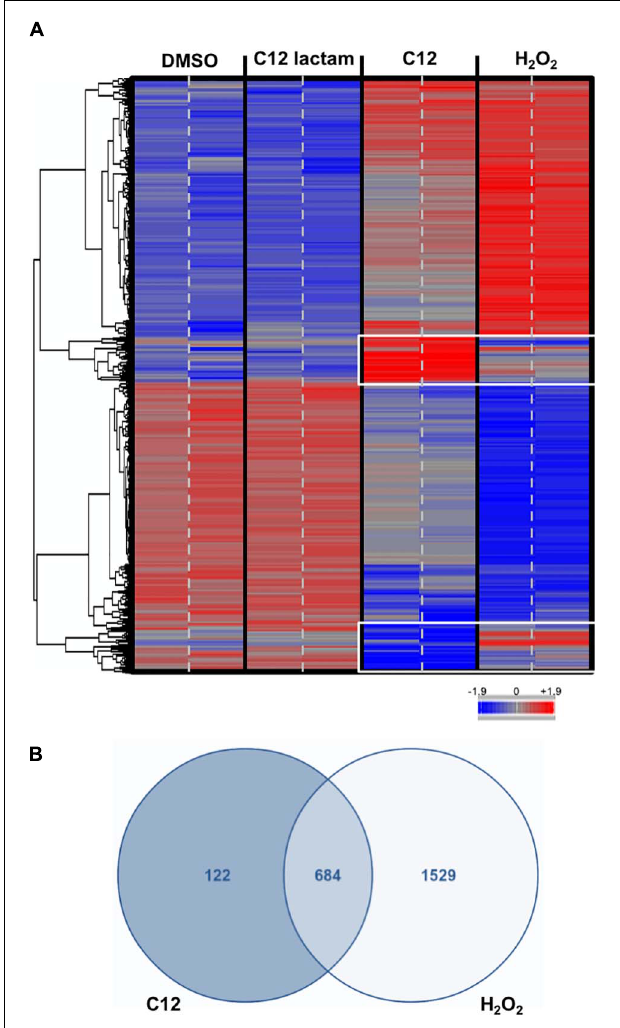
FIGURE 2 | Microarray analysis reveals changes in gene expression specific to C12. (A) . The heatmap shows the gene expression profile after exposure to controls (DMSO control, C12-lactam and oxidative stress) and C12. Down-regulation shown in blue, up-regulation shown in red. The expression profile after exposure to C12 is clearly different from the controls. Oxidative stress and C12 show a similar general trend in gene expression, but several expression changes are unique to C12 (white frame). The microarray results from two chips for each treatment are shown; samples were measured in triplicate, but one replicate was excluded (see Supplementary Figure 1 ). (B) . Of the 806 genes that underwent expression changes due to C12 treatment, 122 (15%) were unique to C12, whereas 684 were